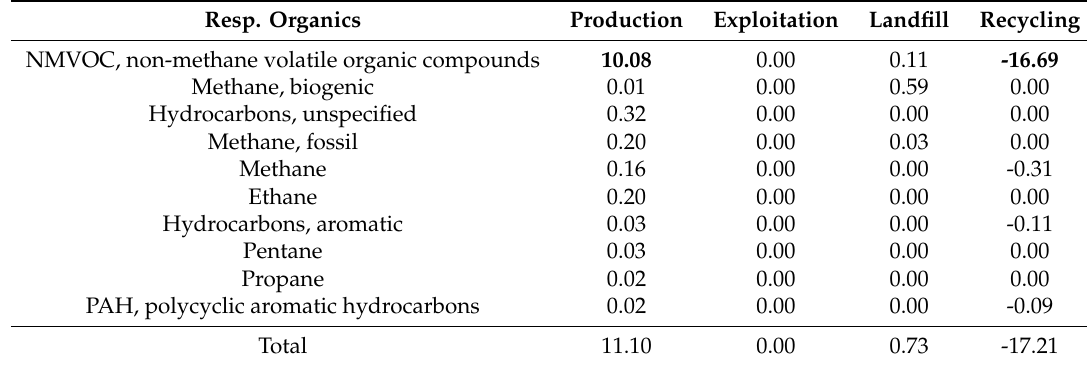
Table 5. Results of grouping and weighting of environmental after-e ff ects for organic compounds causing respiratory diseases, occurring in the 1 megawatt photovoltaic power plant [unit: Pt].